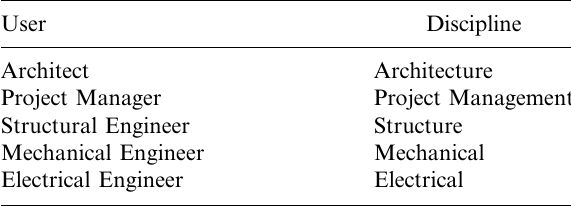
Table 2. Project disciplines and